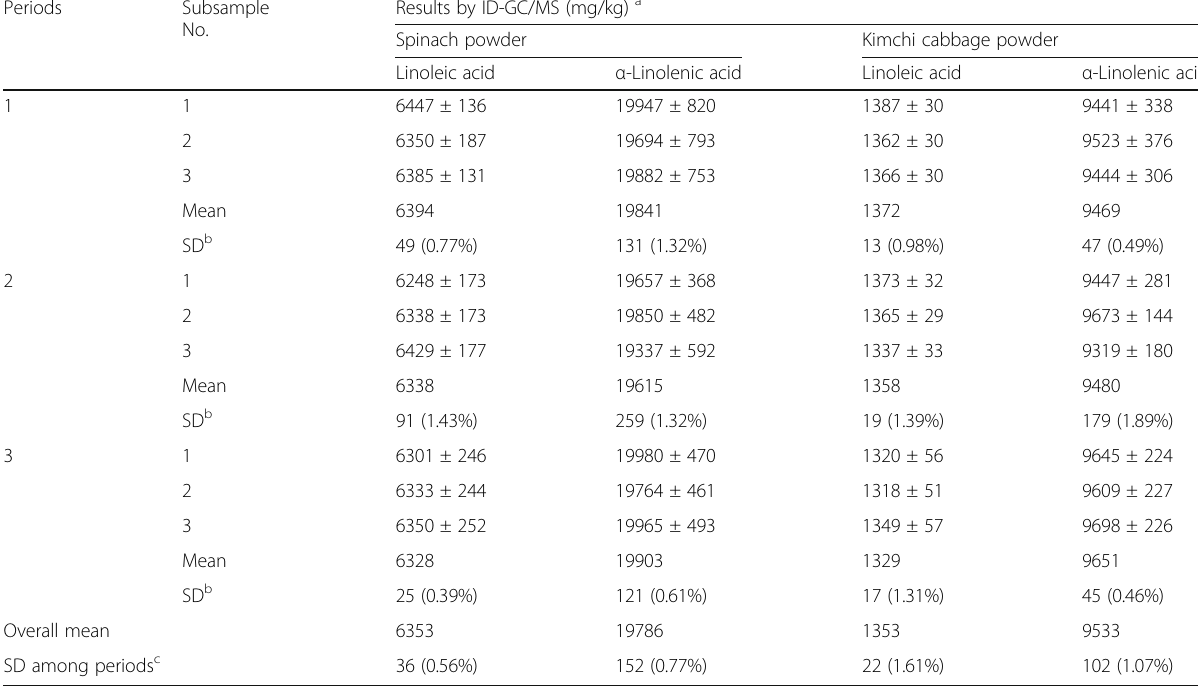
Table 2 Results of ID-GC/MS measurements for homogenized samples of spinach and kimchi cabbage powders at three different time periods Periods